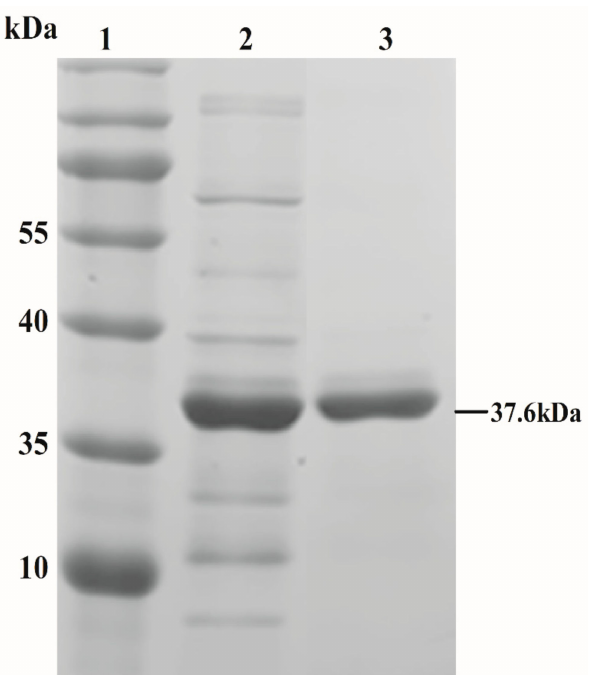
Figure 1. Analysis of purified lysin from Streptococcus prophage phi5218 (Ply5218) by sodium dodecyl sulfate polyacrylamide gel electrophoresis (SDS-PAGE) assay and Coomassie brilliant blue staining. Lane 1, ladder; lane 2, crude protein extracted from IPTG-induced E. coli BL21 (DE3) cells producing